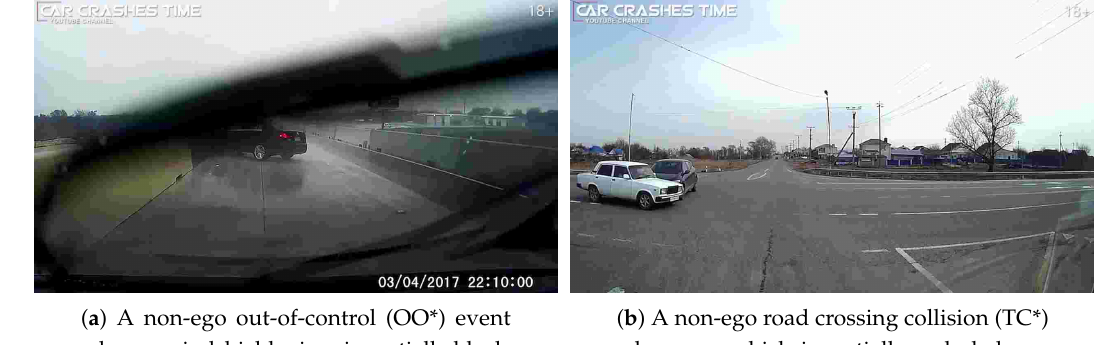
Figure 3. Compressed anomaly failure cases. * indicates non-ego.